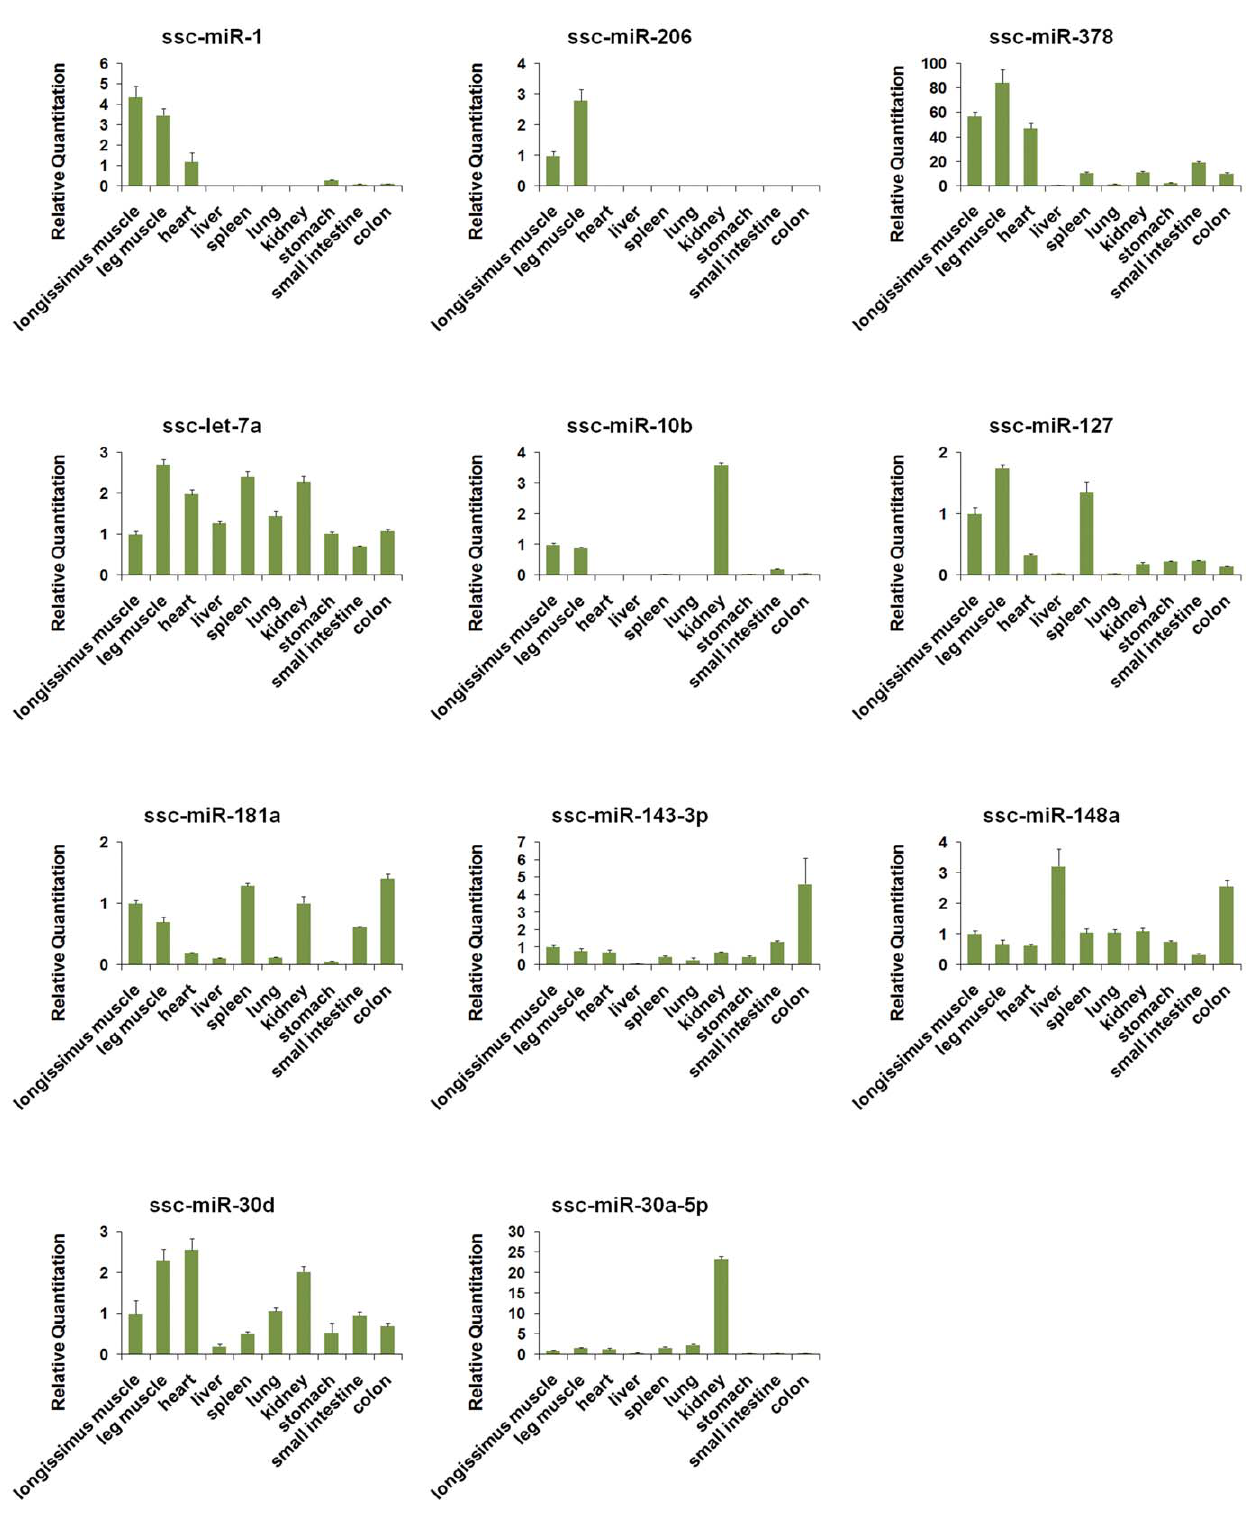
Figure 2. Expression profiles of several high-abundance miRNAs using stem-loop RT-PCR. Total RNAs were isolated from longissimus muscles, leg muscles, heart, liver, spleen, lung, kidney, stomach, small intestine and colon. The expression levels were analyzed using the DD Ct method and normalized against U6. Each sample was run in triplicate, and the calculation standard deviation was shown. doi:10.1371/journal.pone.0052123.g002 was expressed in an extremely low level in their results. These fetal stages and play vital roles in the regulation of fetal differentially expressed miRNAs may be highly expressed during myogenesis. These results also demonstrate that including many